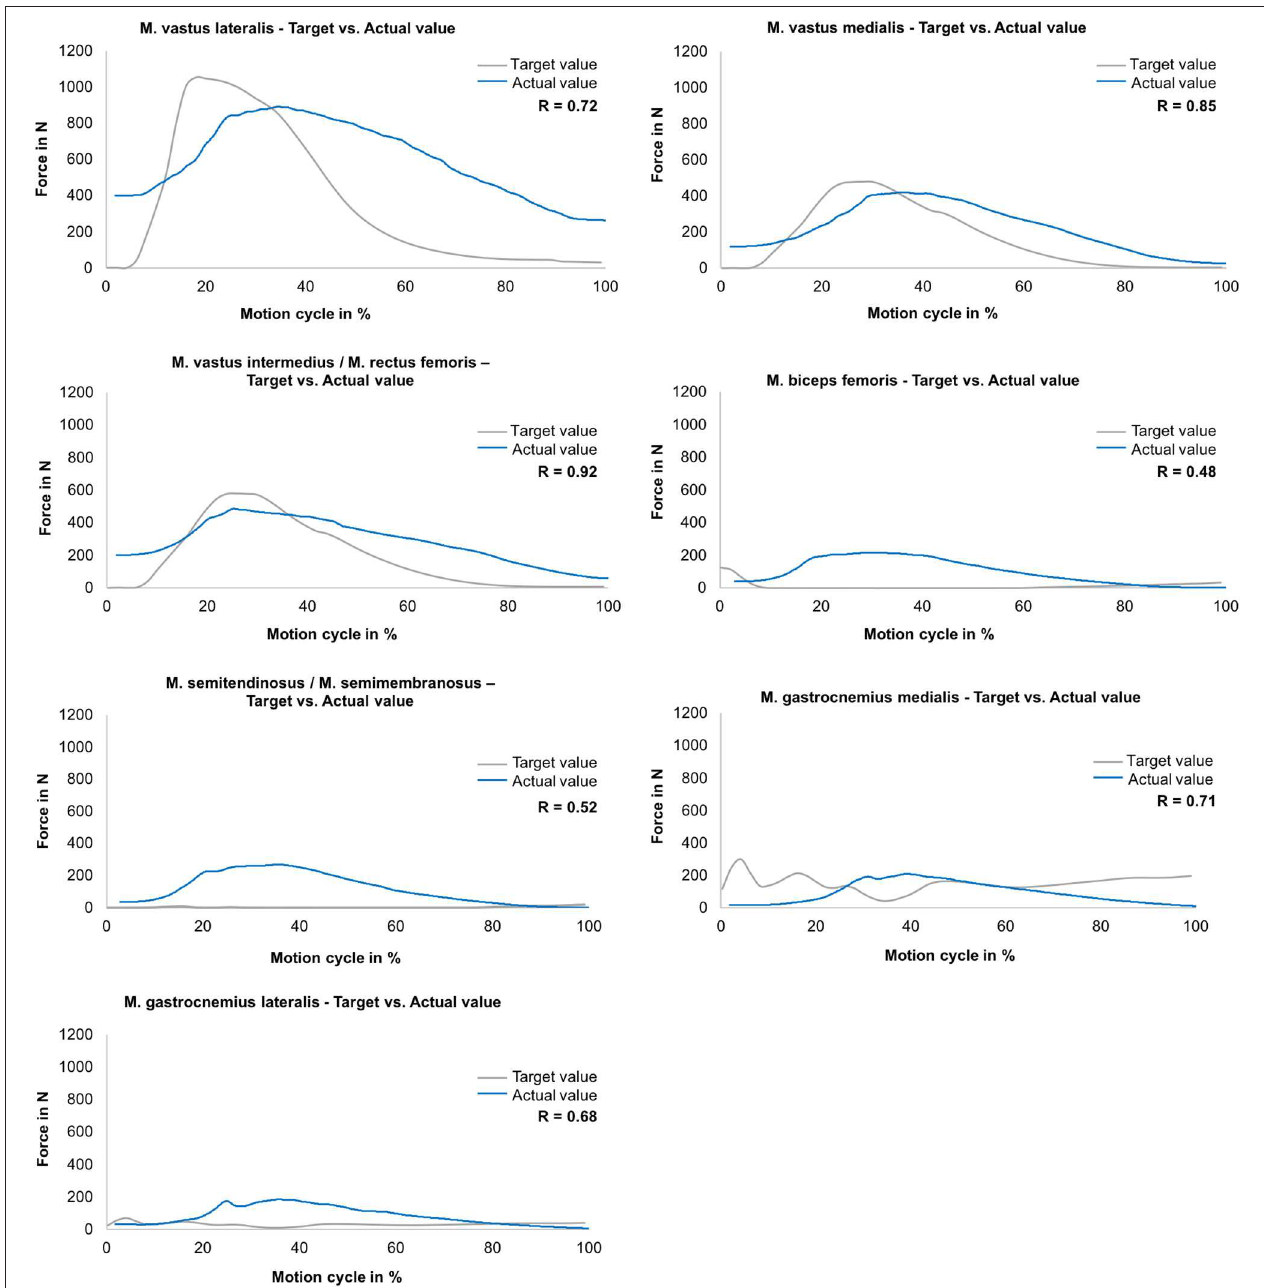
FIGURE 4 | Muscle force simulation—comparison between the actual (mean values) and target muscle forces (gained in MAID study) as a function of the motion cycle (duration: 540ms) during jump landing for M. vastus lateralis, M. vastus medialis, M. vastus intermedius/M. rectus femoris, M. biceps femoris, M. semitendinosus/M. semimembranosus, M. gastrocnemius medialis and M. gastrocnemius lateralis ( n = 9).